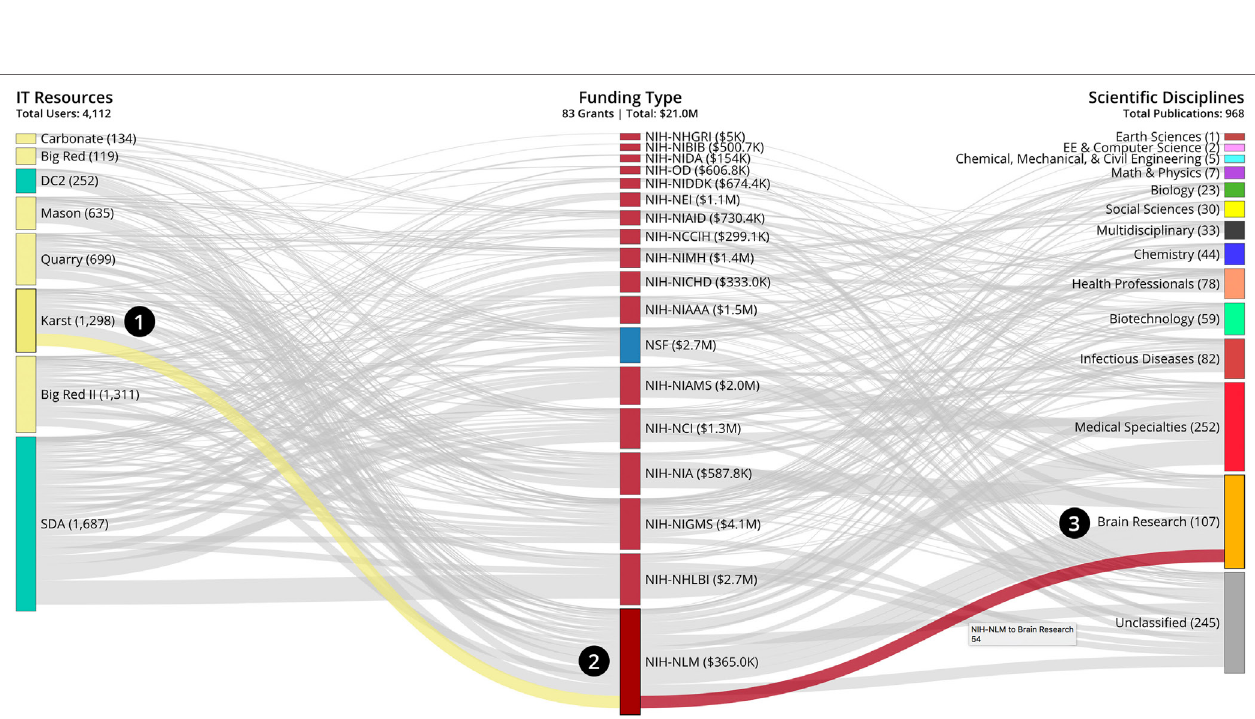
FigUre 5 | XD metrics on demand value analytics Portal, see interactive version at